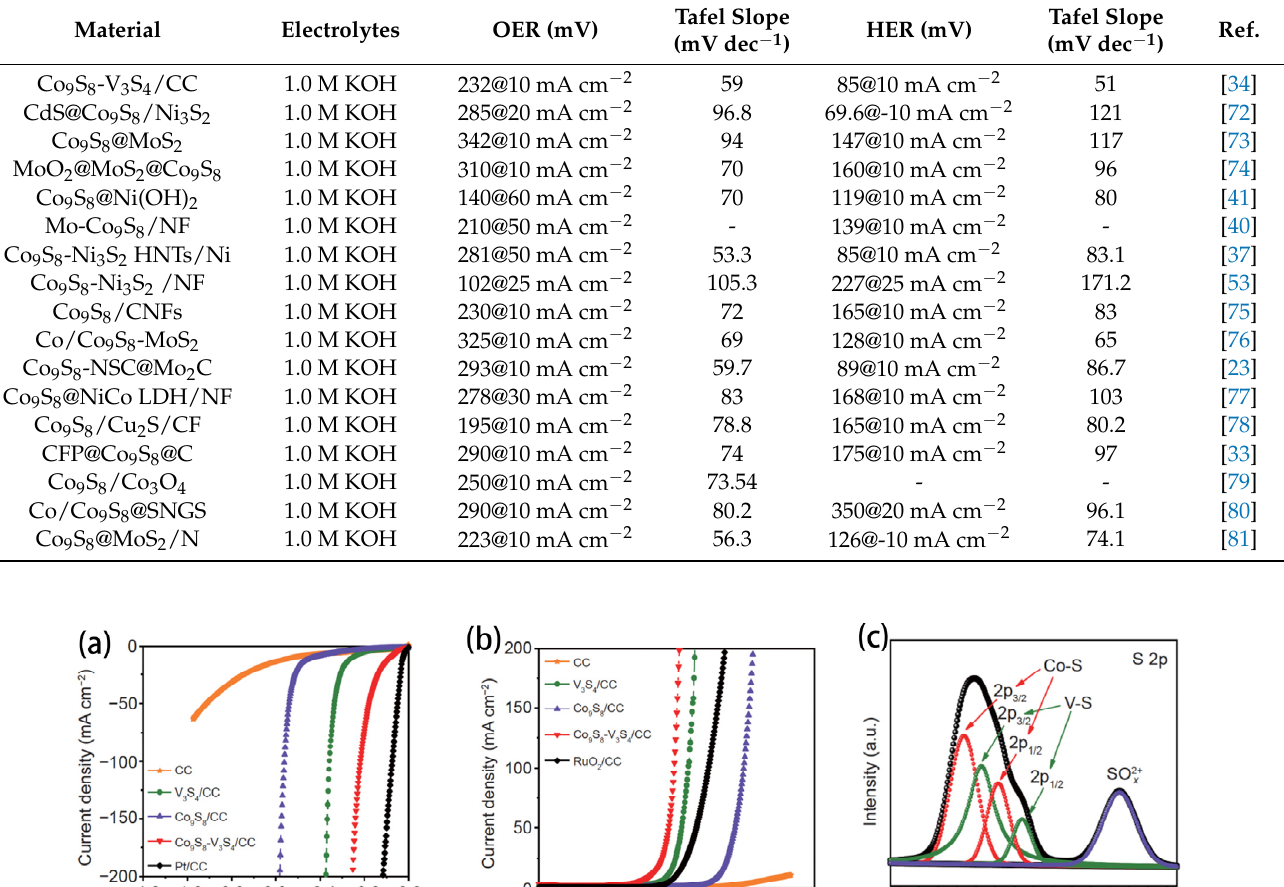
Table 1. Electrocatalytic Activity of Co 9 S 8 -Based materials.